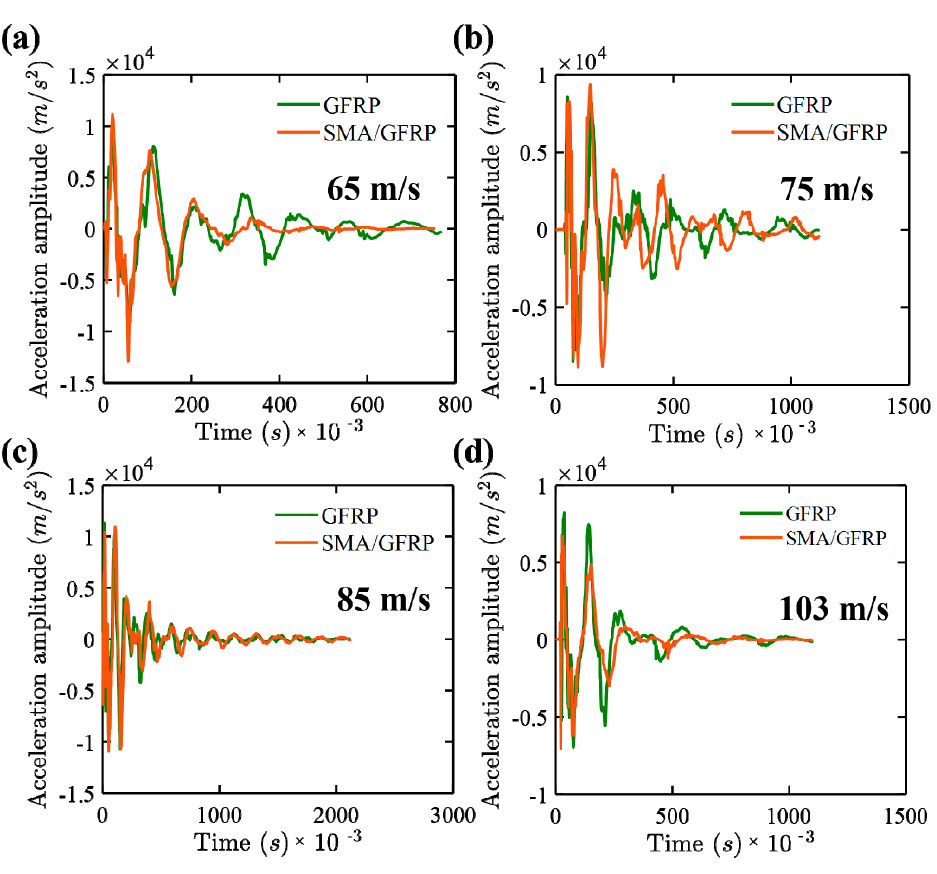
Figure 8. Acceleration–time response for the GFRP and SMA/GFRP specimens at different impact velocities ( a ) 65 m/s, ( b ) 75 m/s, ( c ) 85 m/s, and ( d ) 103 m/s (zoomed version of this plot is provided in Figure S1—Supplementary Materials). Table 6. Comparison of maximum acceleration for the GFRP and SMA/GFRP specimens at different impact